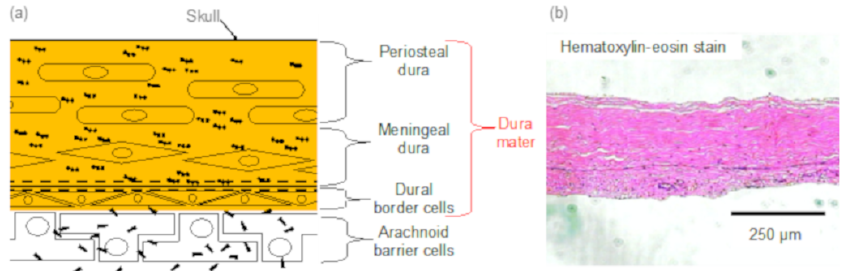
Figure 2. Dura-mater: ( a ) Cross-sectional structure of dura-mater; ( b ) Cross-sectional photograph of porcine dura-mater after hematoxylin-eosin (HE)